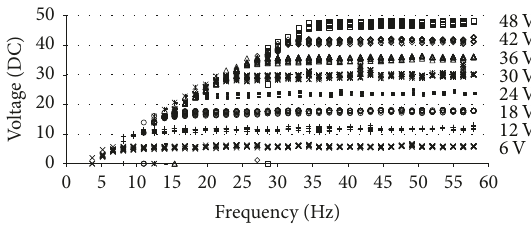
Figure 7: Voltage generation for different frequencies.